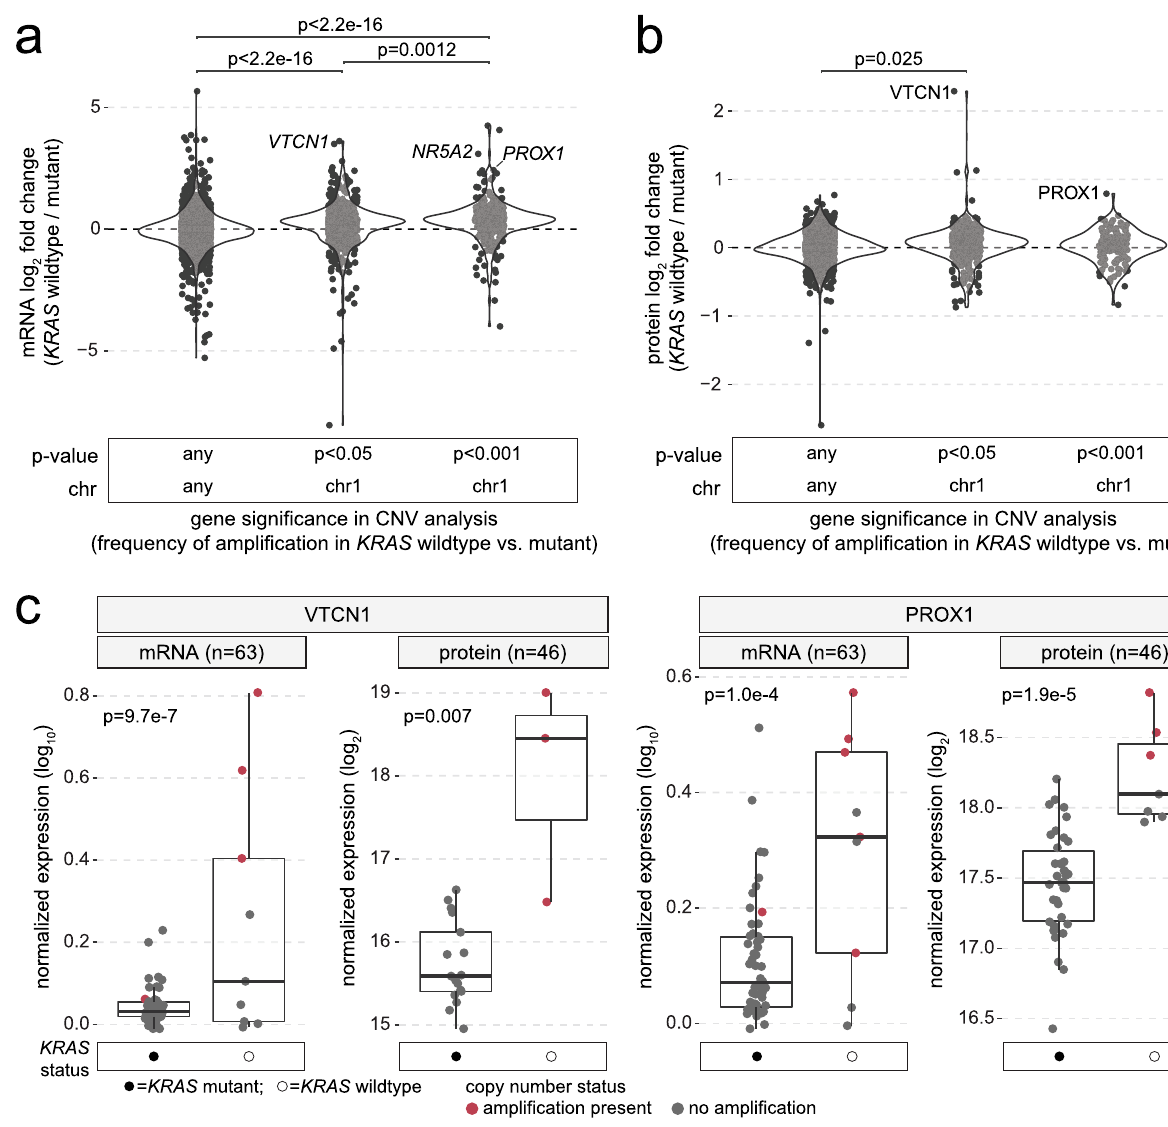
Fig.4| VTCN1 and PROX1 areincreasedin KRAS wildtypemPDACatbothmRNA and protein levels. a Violin plots showing distribution of mRNA expression fold changes (log 2 ; KRAS wildtype vs. mutant) for genes grouped according to results ofCNVanalysisbetween KRAS wildtypeversusmutanttumors.Lefttoright:genes located on any chromosome with no difference in rate of copy ampli fi cation in KRAS wildtype tumors, genes located on chr1 with a signi fi cantly higher rate of copy ampli fi cation in KRAS wildtype tumors above thresholds of p <0.05 and p <0.001. Each dot represents a gene. Two-tailed Wilcoxon mean rank-sum p values are shown. b Violin plots showing the distribution of protein-level fold changes (log 2 ; KRAS wildtype vs. mutant) for genes grouped according to results